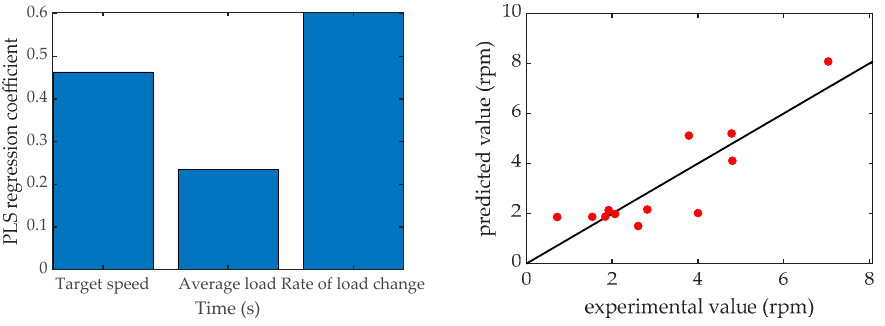
Figure 17. Influence of the parameter on the output speed’s maximum deviation from the average value.